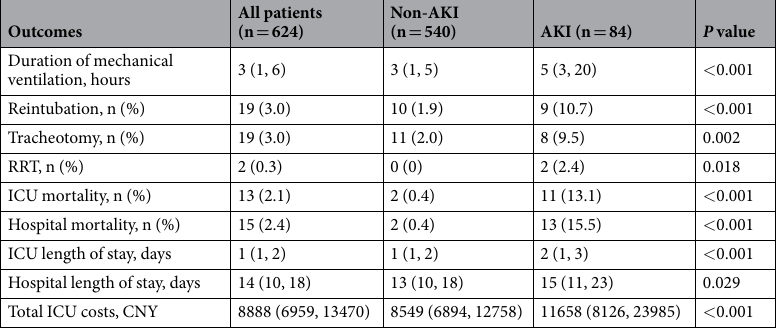
Table 5. Postoperative Clinical Outcomes by Status of AKI a . a Continuous variables were expressed as mean ± SD or median (25th percentile–75th percentile, IQR); Categorical variables were expressed as a number (%). Abbreviations: AKI, acute kidney injury; RRT, renal replacement therapy ICU, intensive care unit; CNY, Chinese